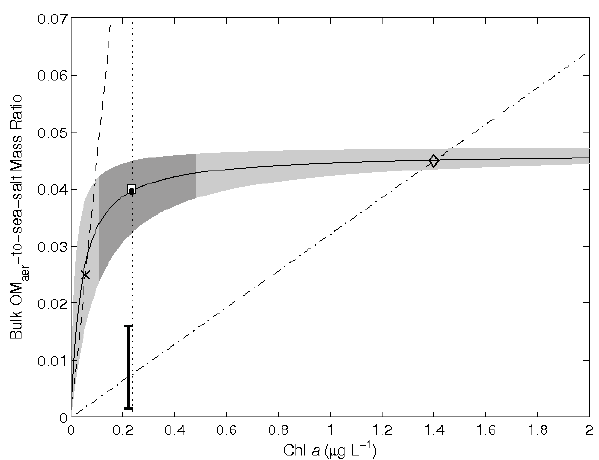
Fig. 3. Comparison of Langmuir versus linear extrapolations of the bulk OM aer mass fraction of nascent marine aerosol as a func- tion of chl- a in seawater. The solid line depicts the fit of the mean OM aer data (Table 1) from low- (X; Keene et al. (2007) and high- productivity (diamond; Facchini et al., 2008) waters to a Langmuir model as described in the text. The gray shaded area depicts uncer- tainty around the fit associated with reported variability in the mea- sured mass ratios of OM aer to sea salt (Table 1). The dark shaded area corresponds to uncertainty in the remotely sensed chl- a data (see text). The dashed and dot-dashed lines depict linear extrapo- lations based on the mean results reported by Keene et al. (2007) and Facchini et al. (2008), respectively. The open square is the bulk OM aer mass fraction based on integration of results from the 5-yr CAM simulations using the Long10 parameterization and the solid circle is the corresponding bulk OM aer mass fraction calculated di- rectly from the mean data in Table 1. The vertical dotted line de- picts the mean global chl- a concentration (0.23µgL − 1 ) based on the SeaWIFS data employed in this study. The vertical bar rep- resents the range in the mass ratios of OM aer to sea salt that cor- respond to global OC aer (primary + secondary) emission fluxes of 8TgCy − 1 (Spracklen et al., 2008) based on a global inorganic sea- salt emission flux of 10 3 to 10 4 Tgy − 1 (Table 1) and a global mean chl- a concentration of 0.22mgm − 3 (as inferred from results pre- sented in Spracklen et al.,